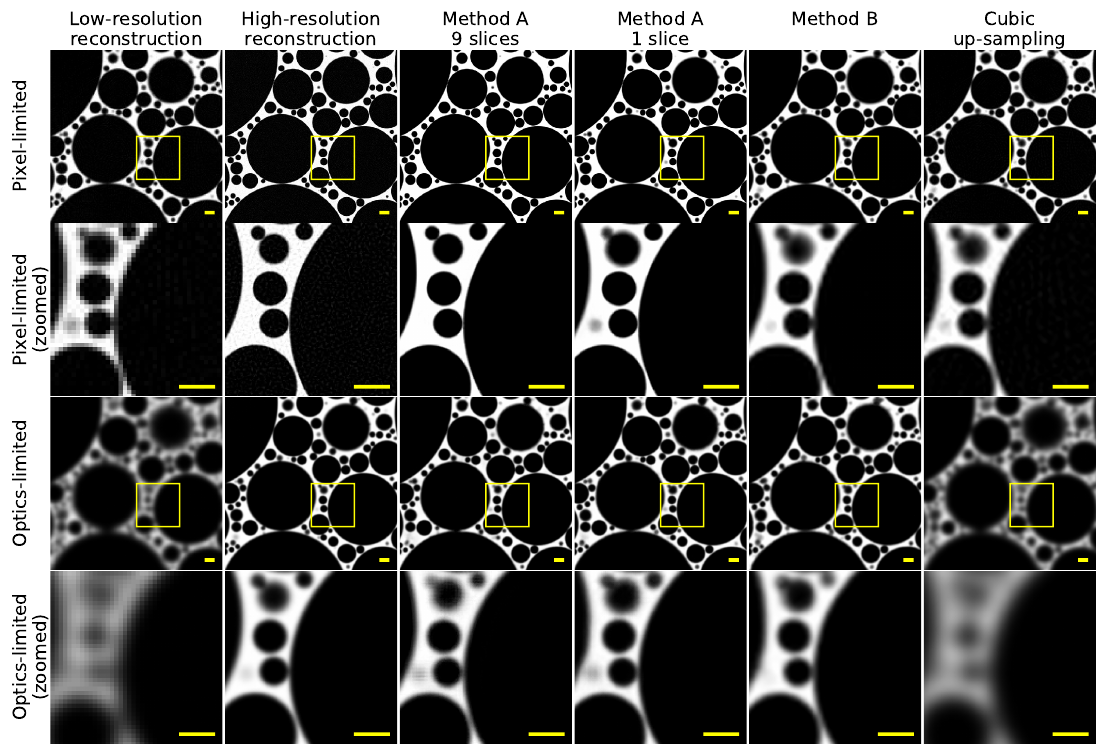
Figure 7. Results of applying the trained networks to the central slice of the upper region of interest. The low-resolution slice (shown left) was not part of the training set. The high-resolution slice is the result of reconstruction (Equation (12)). The images in the right-most four columns are computed from the input using our proposed methods and cubic up-sampling. Magnifications of the central yellow square are displayed in the even rows. The first row displays the results on the non-blurred foam phantom reconstructions, and the third row displays the results on reconstructions of blurred foam phantom projections. The output of method B is cubically up-sampled by a factor of 4 to be the same size as the other